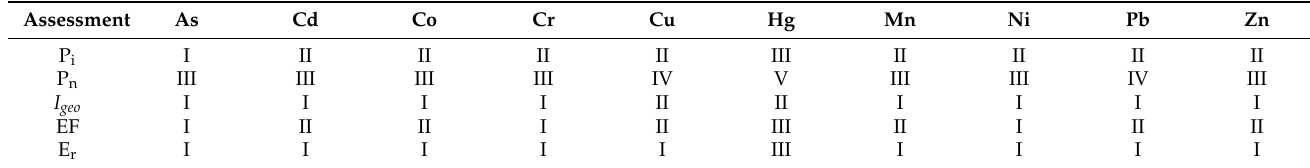
Table 8. Pollution grades of each element with different assessment methods.